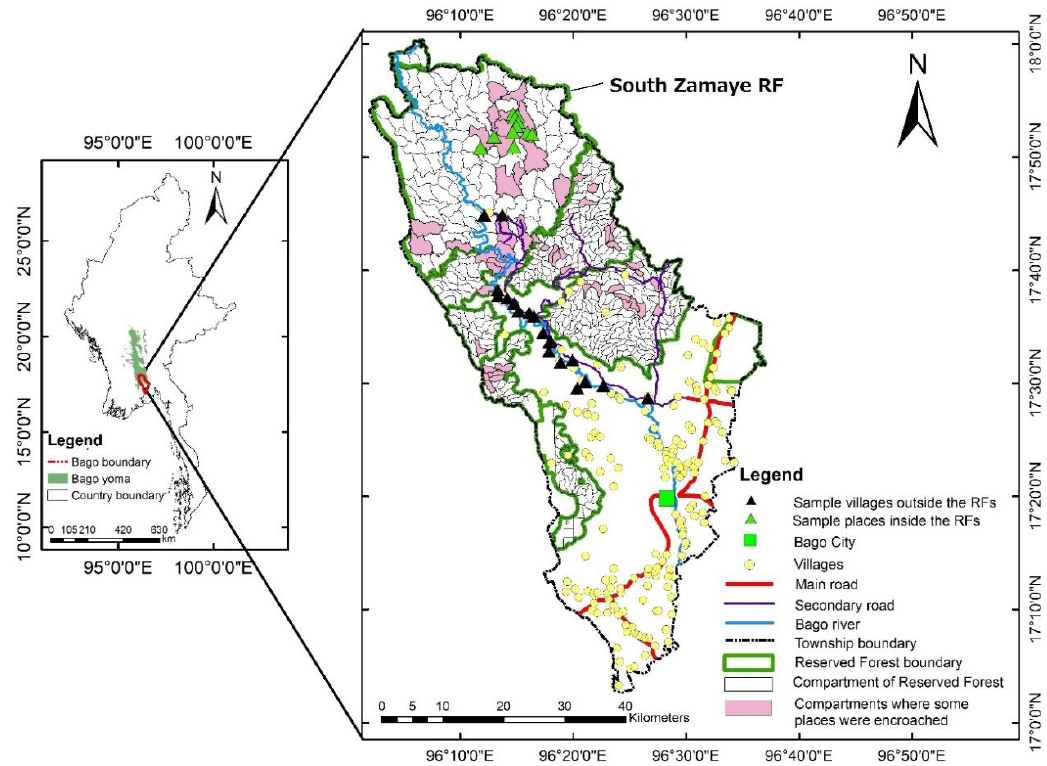
Figure 1. Study sites at Bago Township, Myanmar.